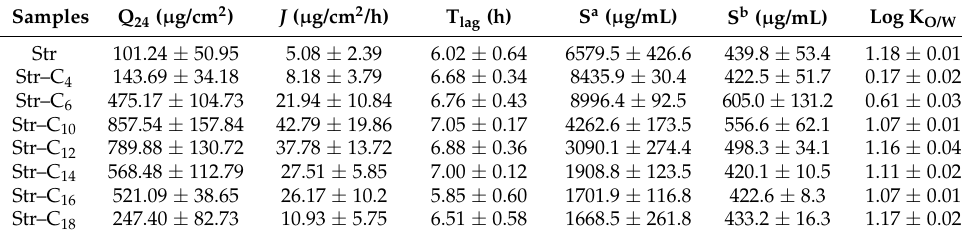
Table 2. Skin permeation data of Str and its ion-pair